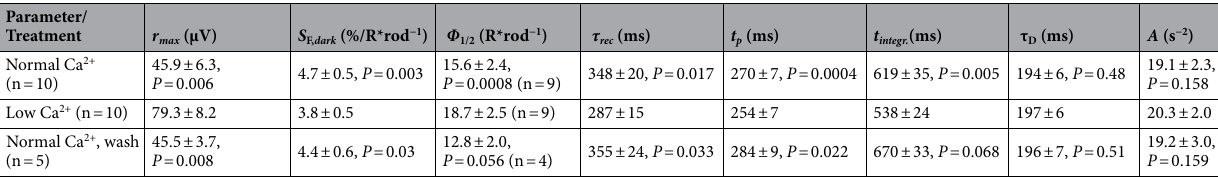
cGMP clamp. In the rod photoreceptor cytoplasm without any stimulating light, the rate of cGMP synthesis by guanylate cyclase, α dark , and the rate constant of cGMP hydrolysis by basal PDE6 activity, β dark , determine the